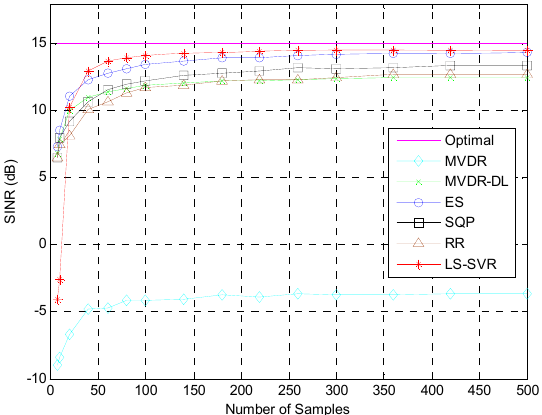
Figure 2. Scenario with limited snapshots and two interferences.